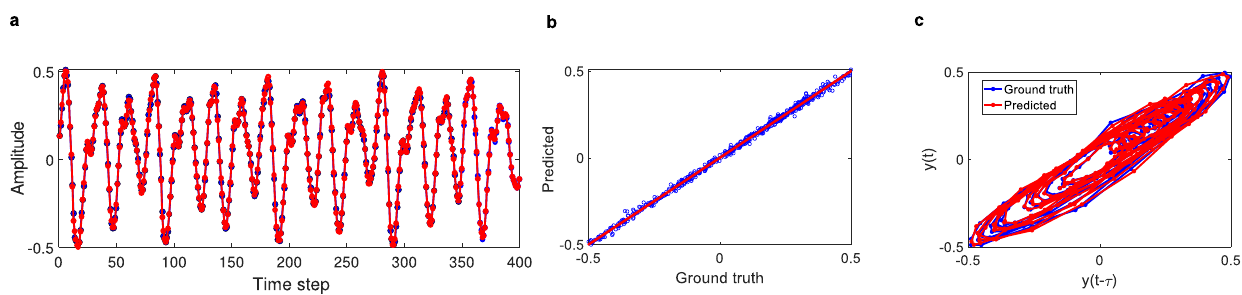
Fig. 7 Floquet reservoir computing for forecasting the chaotic Mackey-Glass time-series. a Training results: The ground truth (blue) and the predicted output from the RC system (red) are plotted. b Corresponding results of linear regression. c Trace of time-series values in phase space, with respect to the previous time-step for both ground truth and predicted values.